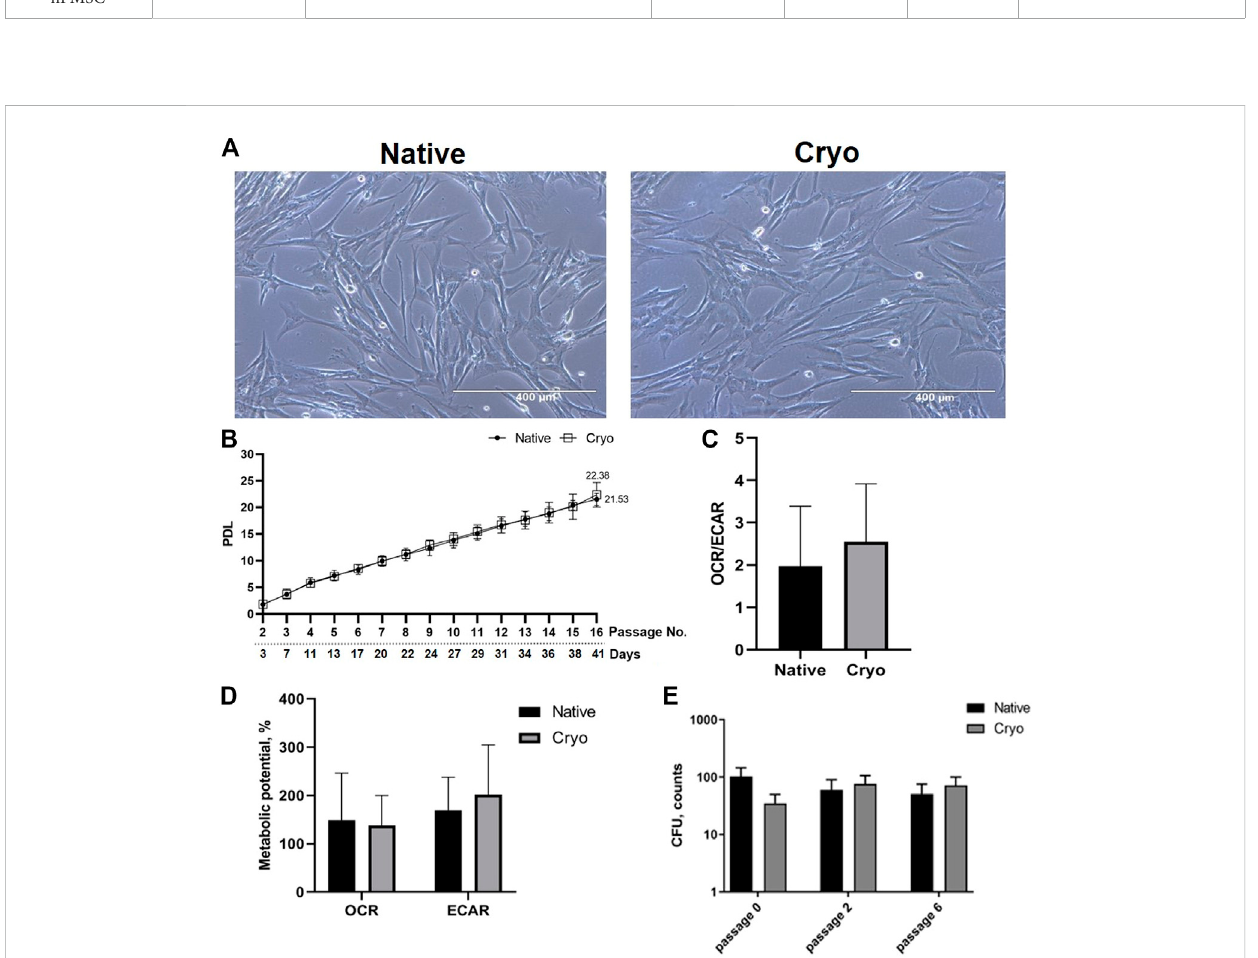
Characterization of hPMSCs by morphology, proliferation, and energetic phenotype. (A) Morphology of isolated and cultured cells derived from fresh placenta tissue (native) and from frozen tissue (cryo). Scale bar = 400 µm (10X objective). (B) Proliferation potential of native and cryo cells. Graph shows population doubling level (PDL), which is based on the initial and fi nal concentration of cells, as well as passages and days in culture. Both cell populations were cultivated from the 2nd to 16th passage. Results are presented as mean ± S.D. ( n = 6). (C) Analysis of the cellular energy consumption pro fi le of native and cryo cells using Seahorse Extracellular Flux Analyzer. The ratio of oxygen consumption rate (OCR) and extracellular acidi fi cation rate (ECAR) was calculated under baseline conditions. Results are presented as mean ± S.D. ( n = 6). (D) Assessment of metabolic potential changes in hPMSCs (native and cryo) under increased energy demand. OCR and ECAR parameters were measured separately under stressed conditions usingSeahorseXFpExtracellularFluxAnalyzer.Alldatawerenormalizedtomicrogramofproteinandpresentedasmean±S.D.( n =6). (E) Nativeandcryo cells did not differ in CFU activity, and data are presented as median and IQR (inter-quartile range), n =